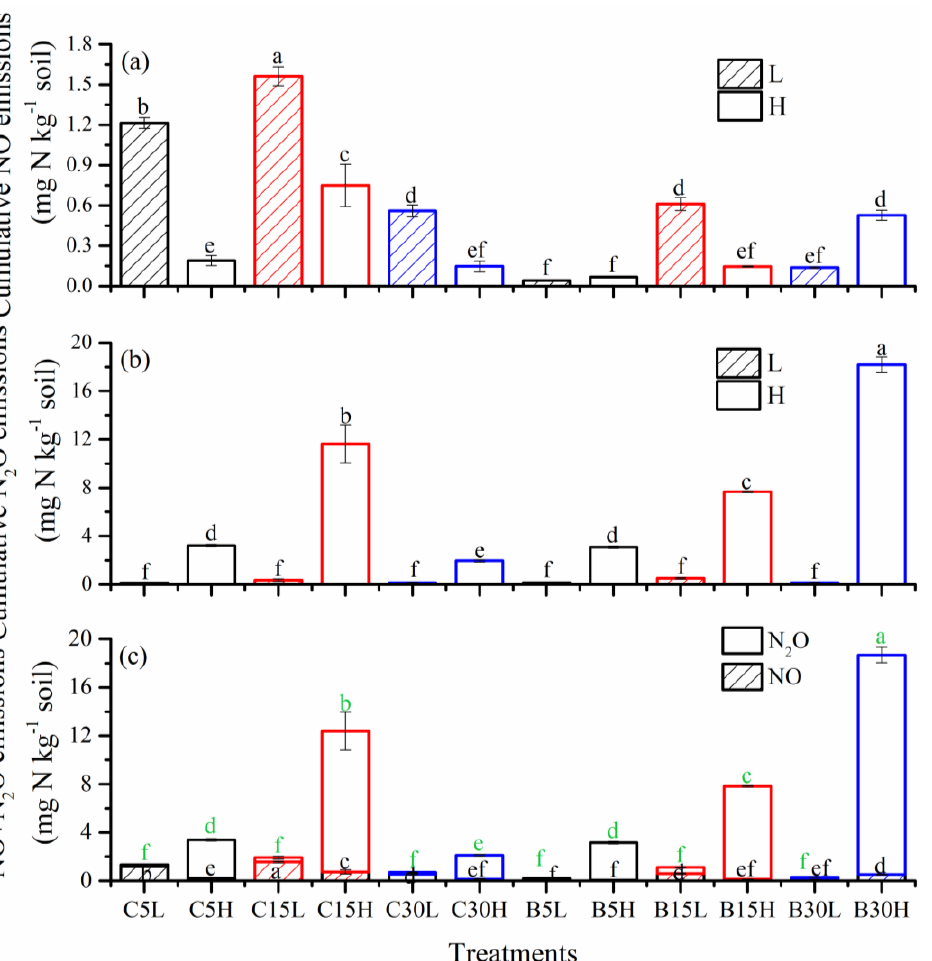
Figure 5. Soil cumulative NO (a), N 2 O (b) and NO+N 2 O (c) emissions during 71-day incubation period. L: 50% WFPS, H: 80% WFPS. 5, 15, and 30 represent soil under 5-y, 15-y, and 30-y tea plantations. Error bars indicate standard deviation. Different letters refer to significant differences between the treatments at the statistical level of 0.05.